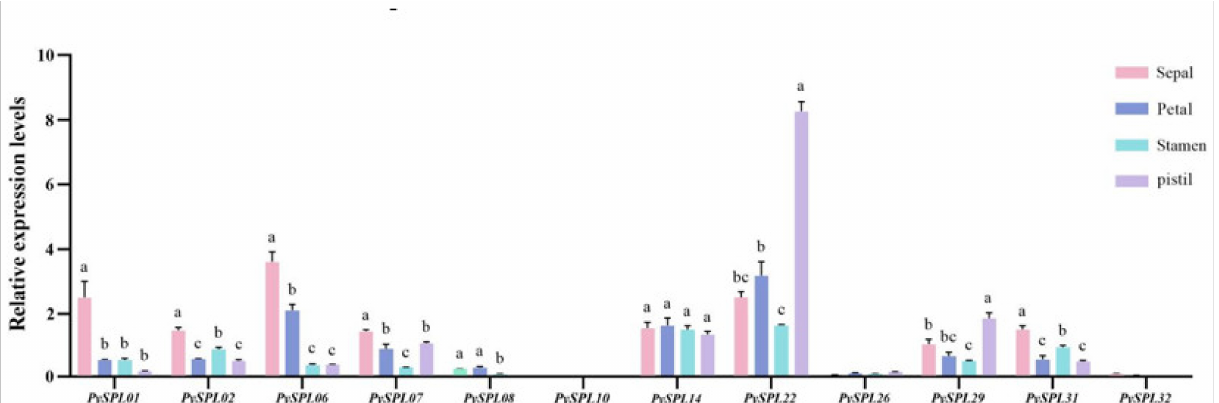
Figure 9. Expression of PySPLs in different floral organs in Prunus × yedoensis ‘Somei-yoshino’. All samples were collected at blooming stage (0DBF). Each value is shown as average ± standard deviation from three biological replicate samplings. p < 0.05 for significance. a, b, c and d represent the level of significant difference between different samples, the difference between samples with the same letter is not significant; the greater the difference of letters, the more significant the difference between